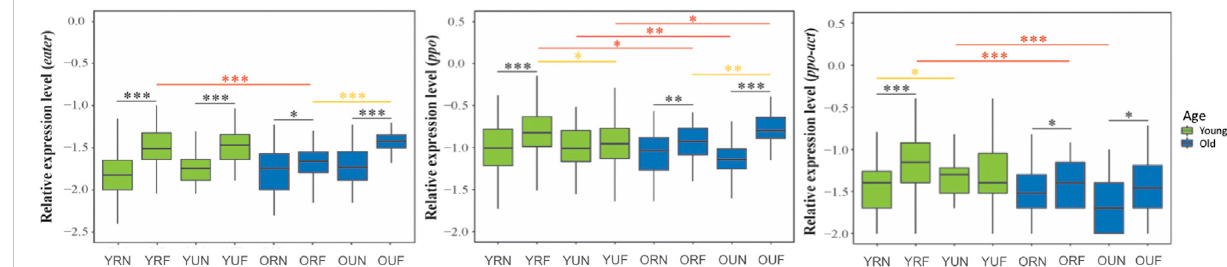
FIGURE 4 Expressionofgenesinvolvedwiththecellularimmuneresponse.SamplenotationisasinFigure2.Black,yellowandredasterisksillustratesigni fi cant differences between behavioral, nutritional, and age groups. * p < 0.05; ** p < 0.01. *** p <